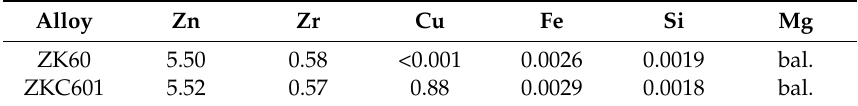
Table 1. Chemical compositions (wt %) of the ZK60 and ZKC601 alloys investigated in this